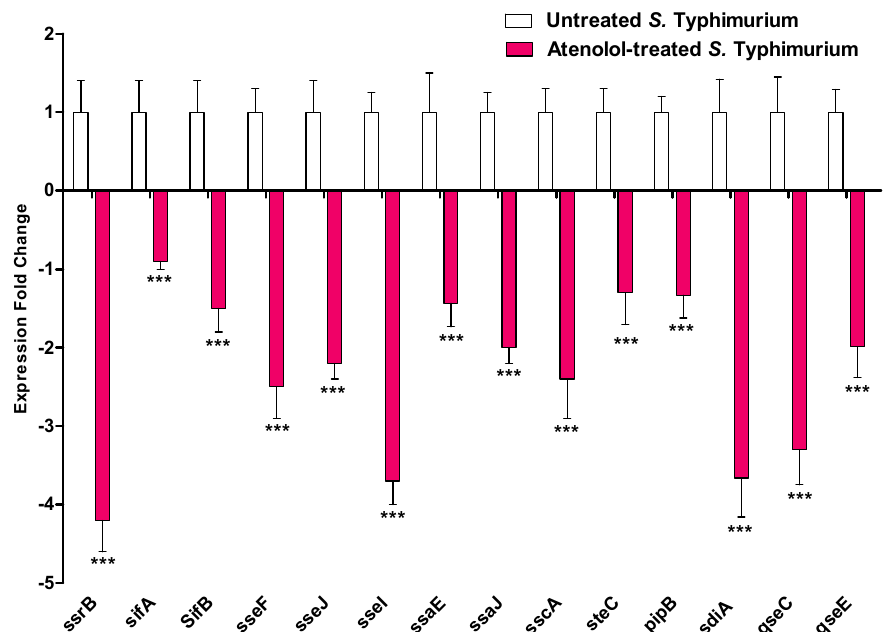
Figure 4. Effect of atenolol at sub-MIC on the expression of S. typhimurium virulence encoding genes. The expression of the QS encoding gene sdiA and the norepinephrine membranal sensor encoding genes, qseC and qseE , and TTSS encoding genes ssrB , sifA, sifB, sseF, sseJ. sseI, ssaE, ssaJ, sscA, steC , and pipB were normalized to gyrB housekeeping gene in the presence of atenolol in comparison to untreated controls. Atenolol significantly downregulated the expression of S. typhimurium virulence encoding genes (*** p < 0.0001). The experiment was performed in triplicate and results are expressed as the means ± standard deviation with p value < 0.05 considered statistically significant.